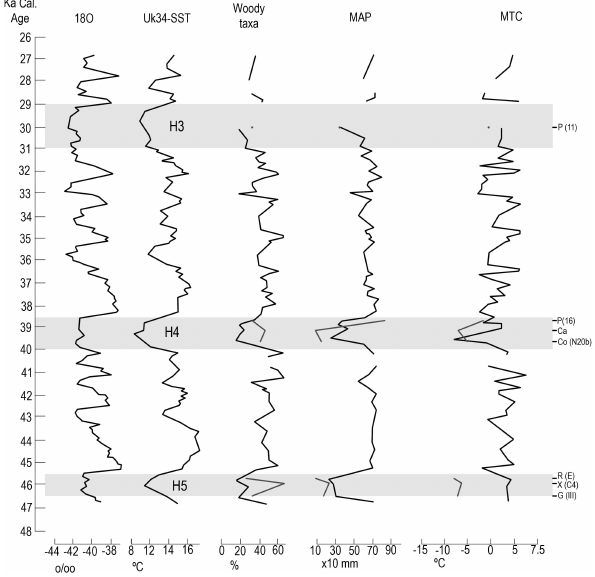
Fig. 8. Proposed correlation of the North GRIP2 isotope ( 18 O) curve, the quantitative variation in the annual sea surface tempera- ture (Uk37-SST), the synthetic pollen diagram from the last glacial section (47–27cal Ka) of core MD95-2043, and the values esti- mated for annual precipitation and mean temperature of the coldest month in southeastern Iberia (modified from S´anchez-Go˜ni et al., 2002) with the various layers with small-vertebrate studies where H3 to H5 events have been detected. P (11 and 16): El Portal´on layer P11 and P16; Ca: Terrassa Riera dels Canyars (Canyars); Co (N20b): Cueva del Conde layer N20b; R (E): Abric Roman´ı layer E; and G (III): Cova del Gegant layer III (grey lines indicate the data obtained with these